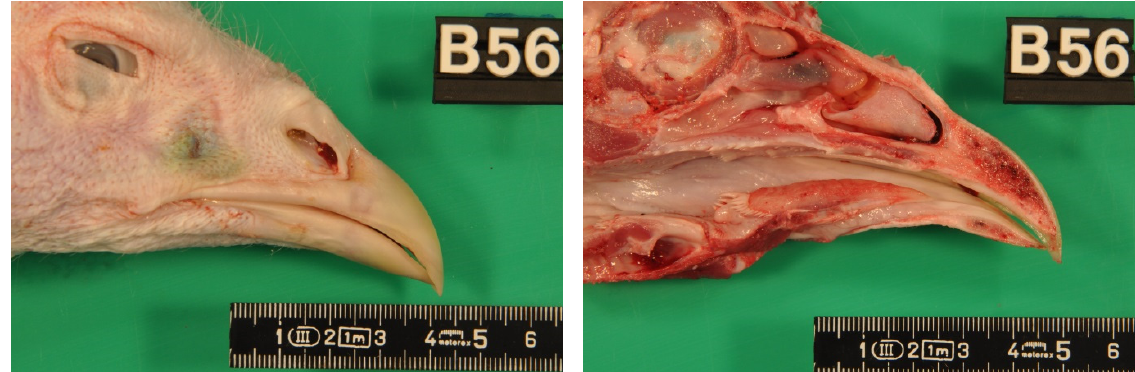
Figure A2. Macroscopic pictures of the turkey heads (also seen in Figure 1) which were split lengthwise with a band saw. On the left side (D52) is an infrared beak trimmed turkey and on the right side (D74) is the head of a turkey which had an integrated screed grinding wheel in the feed pan.